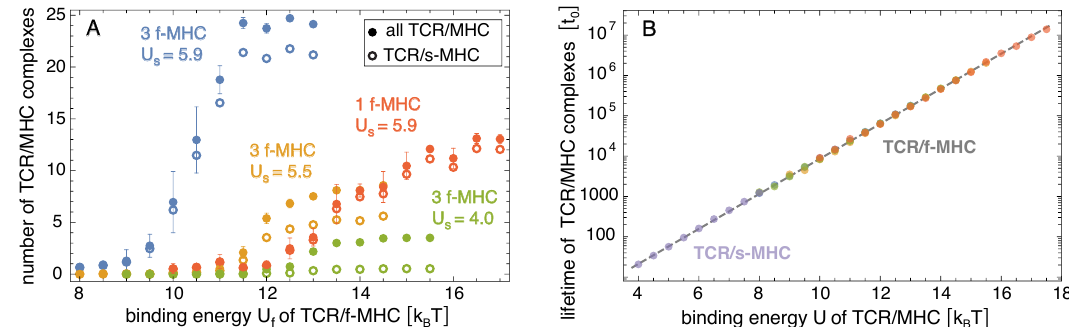
Figure 4. ( A ) Average number of all TCR/peptide-MHC and of TCR/self-peptide-MHC complexes versus binding energy U f of TCR/foreign-peptide-MHC complexes in adhesion scenarios with either three or one foreign-peptide-MHC (f-MHC)and different values of the binding energy U s of TCR/self-peptide-MHCs in units of the thermal energy k B T . ( B ) Average lifetime of TCR/peptide-MHC complexes versus binding energy of the complexes in all adhesion scenarios. The lifetimes of the TCR/self-peptide-MHCs in the adhesion scenario without foreign-peptide-MHCs are shown in purple. The lifetimes of the TCR/foreign-peptide-MHCs in the adhesion scenarios with either three or one foreign-peptide-MHC are shown in the same colors as in ( A ). The dashed line is the regression line exp ( c + U / k B T ) t o of all data points with the single fit parameter c = − 0.945 ±